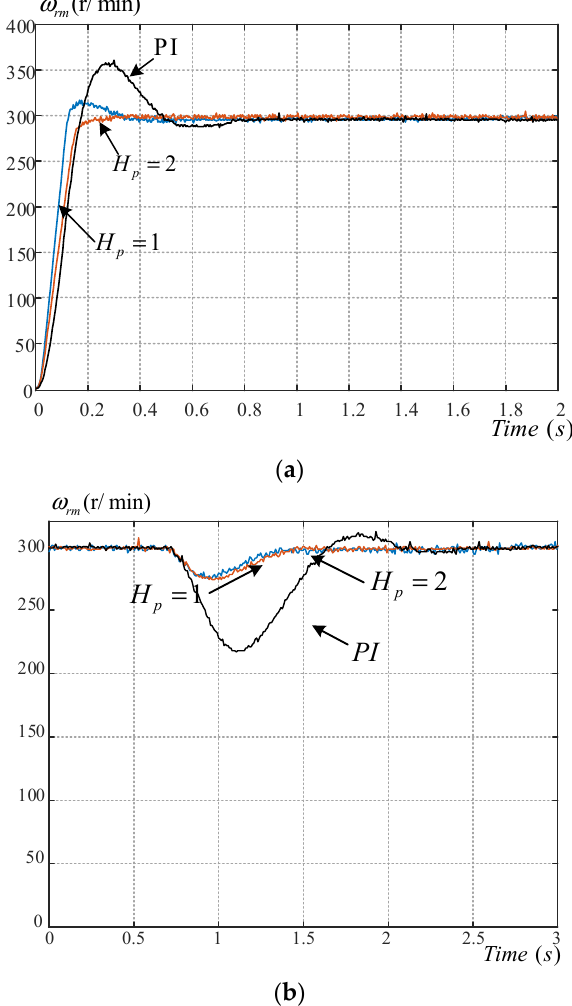
Figure 14. Measured speed responses. ( a ) Transient and ( b ) load disturbance.